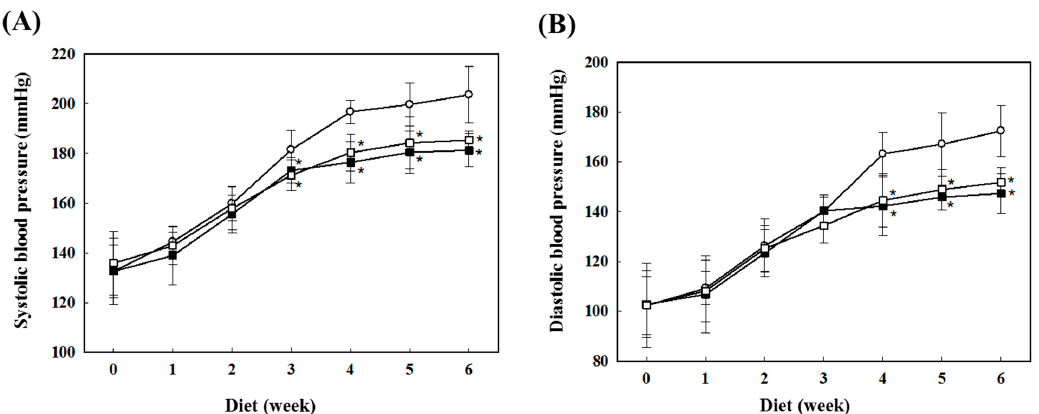
Figure 1. Changes of systolic ( A ) and diastolic ( B ) blood pressure in the rats fed the diets of AS and ASG for 6 weeks. ○ , Control; □ , AS water extract; ■ , ASG water extract. Values are expressed as mean ± SD ( n = 8). * p < 0.05, compared with control (Tukey’s test).